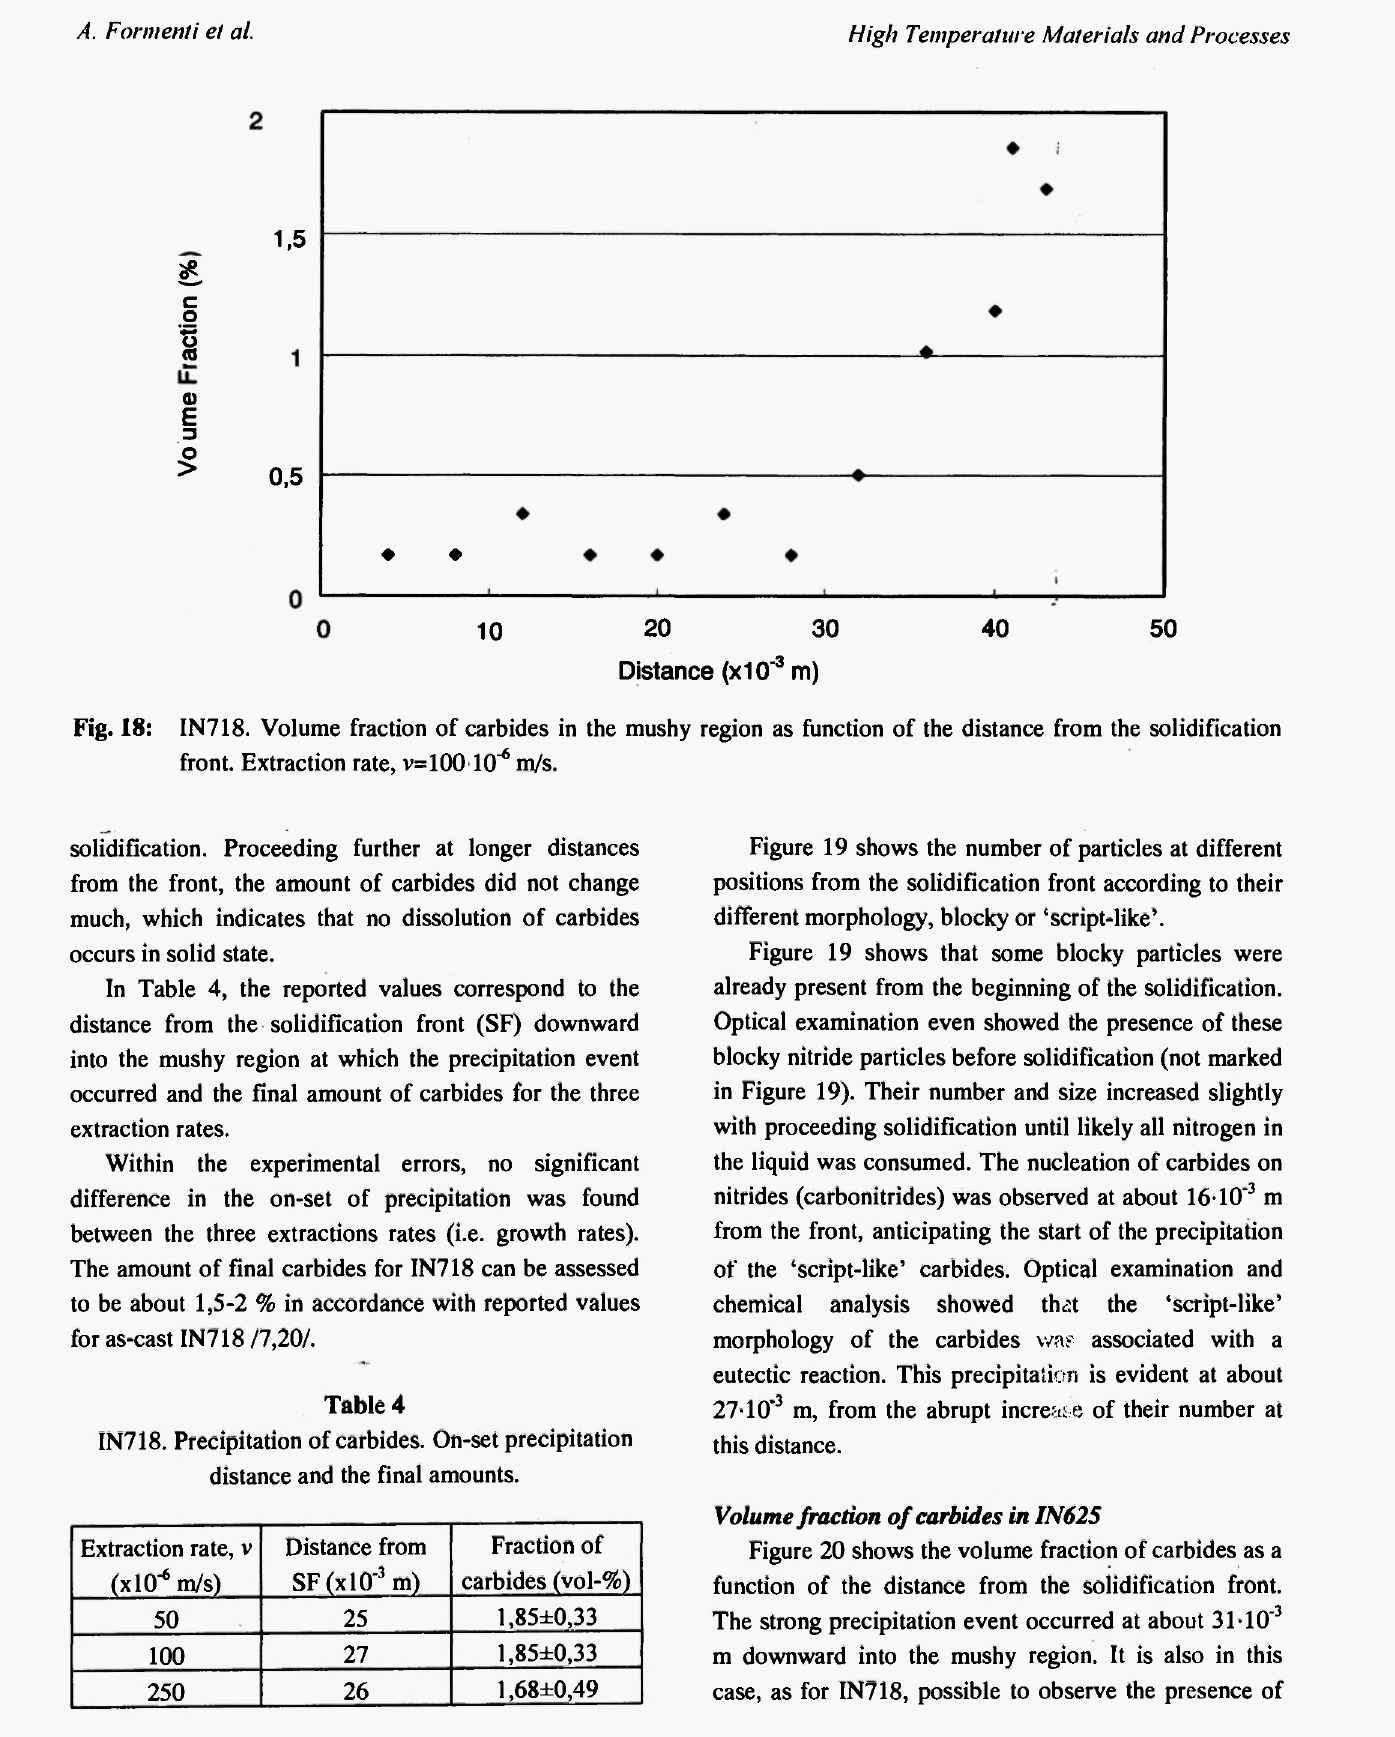
IN718. Precipitation of carbides. On-set precipitation distance and the final